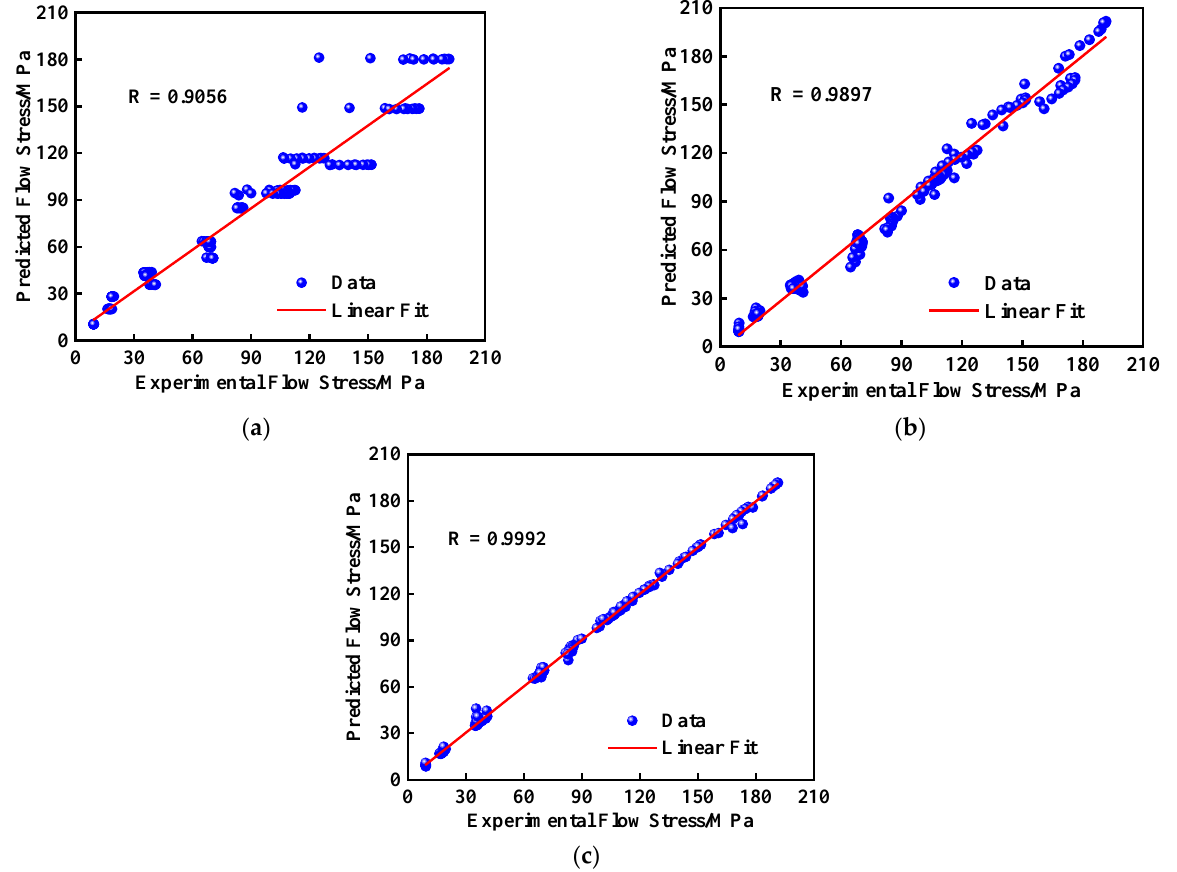
Figure 9. Correlation between the predicted and experimental flow stress by: ( a ) JC model; ( b ) SCA model; ( c ) BPNN model.